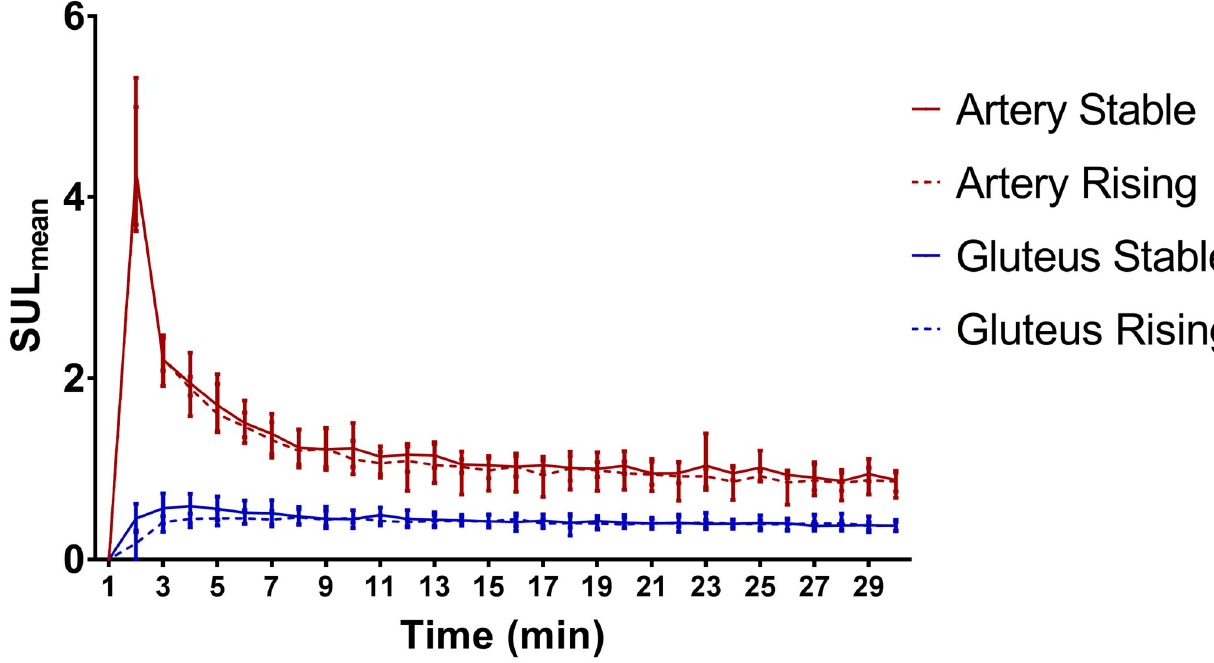
Fig 3. Average time activity curve ( ± range) of the artery and gluteal muscle, separated into two groups with different uptake patterns in the tumour, in blue the stable group and in red the rising